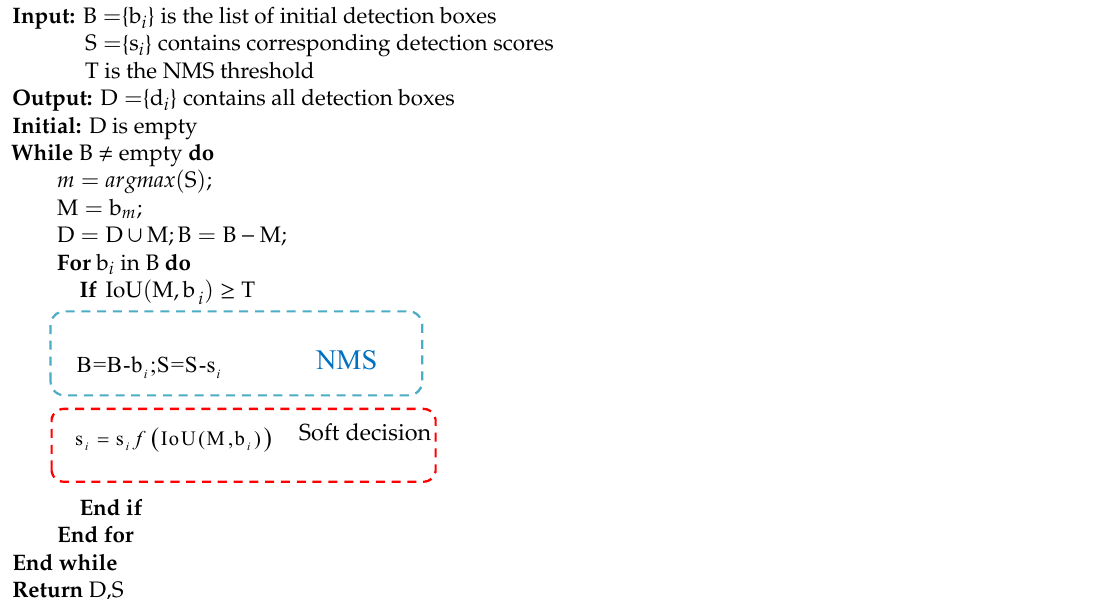
Table 1. The pseudocode of nonmaximum suppression (NMS) based on soft decision.